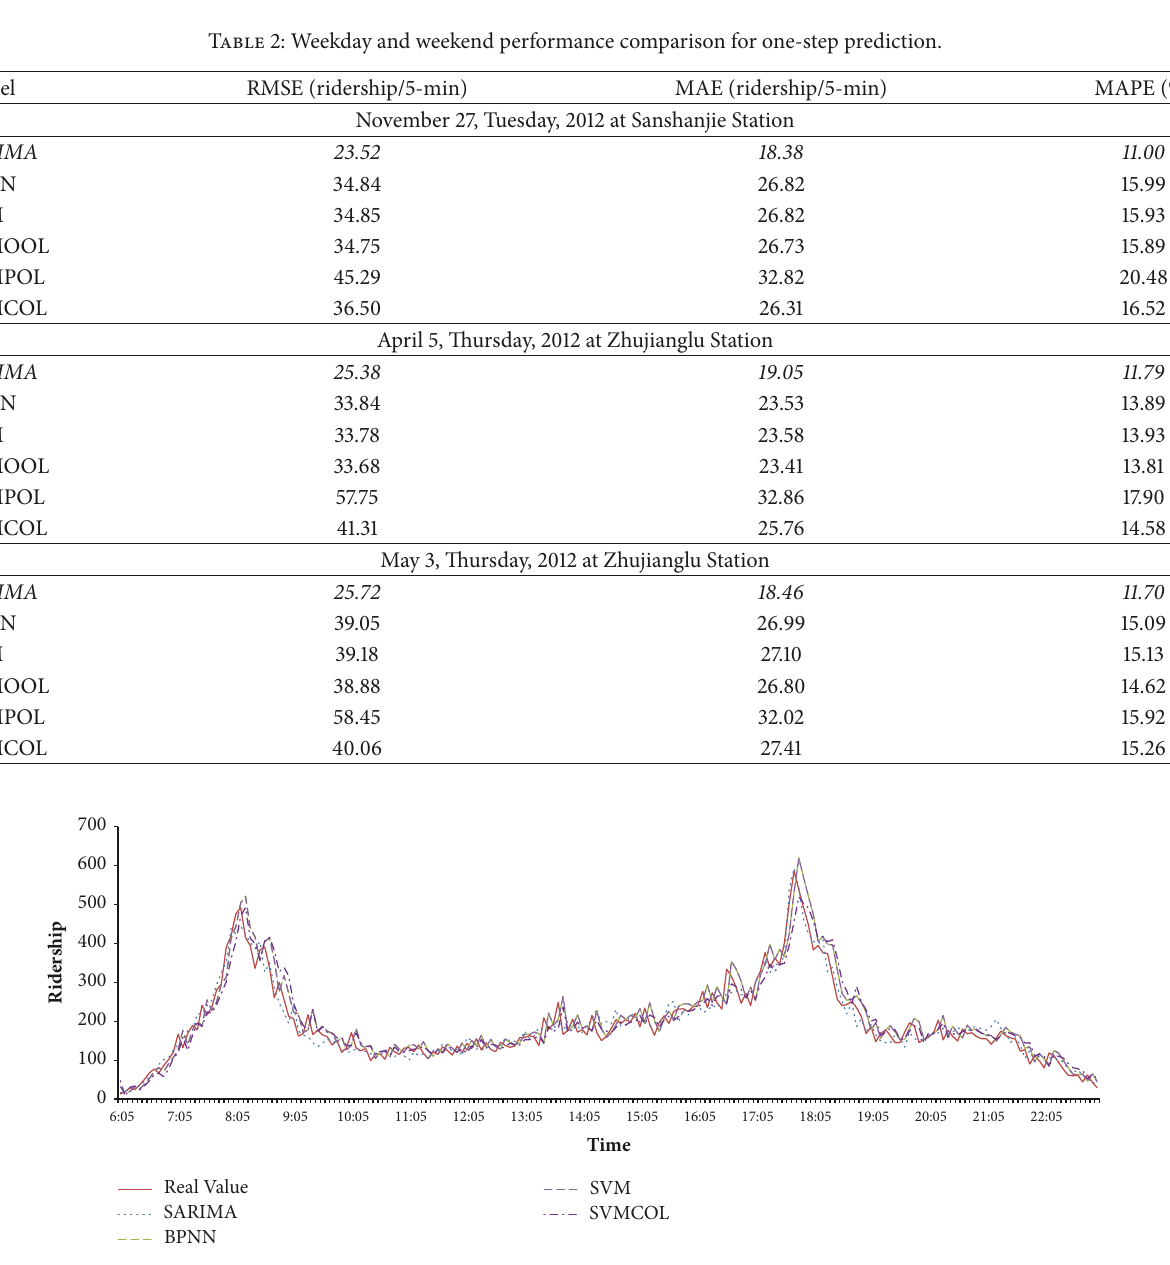
Table 2: Weekday and weekend performance comparison for one-step prediction.